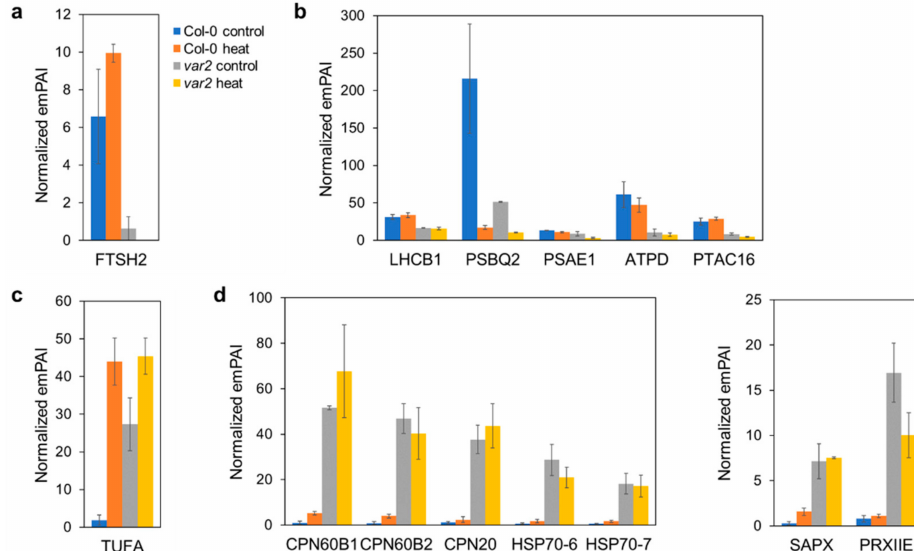
Figure 2. Verification of impaired thylakoid proteostasis and proteotoxic stress responses. Thylakoid-enriched fractions were prepared from heat-stressed and non-stressed wild-type and var2 mutant plants, and their proteins were extracted and analyzed by nanoLC-MS/MS. Protein abundances were quantified and shown as emPAI-based normalized quantitative values (the mean of the two replicates +/ − SD). For more details, refer to Table S1. ( a ) FtsH2 loss. Blue and orange bars indicate the wild-type plants before and after heat stress, respectively, and gray and yellow bars are the var2 mutant before and after heat stress, respectively. ( b ) Misregulated thylakoid protein accumulation. PSBQ2, a subunit of heat-labile oxygen- evolving complex in the thylakoid membrane, was decreased by heat stress and loss of FtsH. Decreased accumulation was also observed for photosynthesis-related and nucleoid-associated proteins. ( c ) An aggregate-prone stromal protein TUFA as a proxy for proteotoxic stresses. ( d ) Recruitment of stromal chaperones and ROS-detoxifying enzymes to the thylakoid membrane in response to the FtsH loss. Left panel indicates chaperone protein abundances. Right panel shows the abundances of ROS-detoxifying